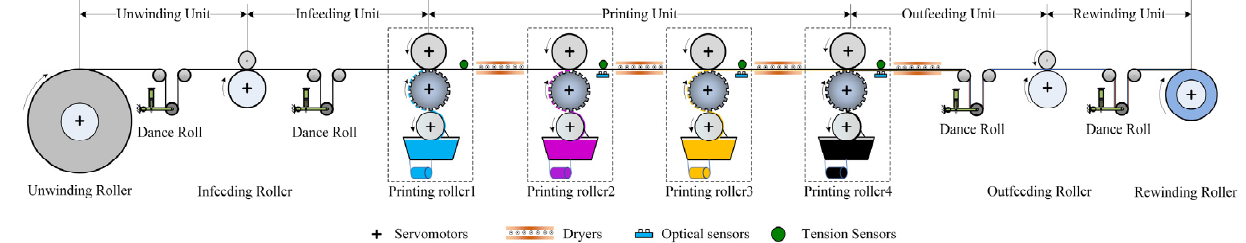
Figure 1. The simplified structure of the flexographic printing machine.